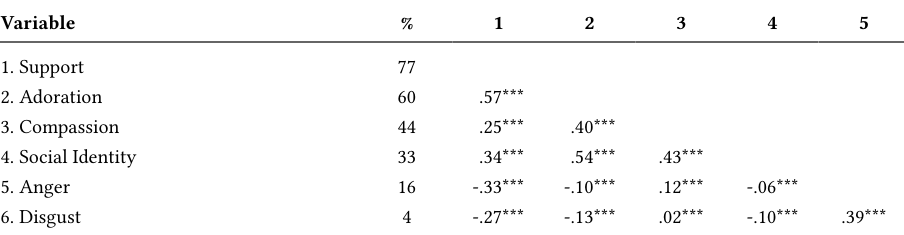
Correlations Between Post-Scandal DDR